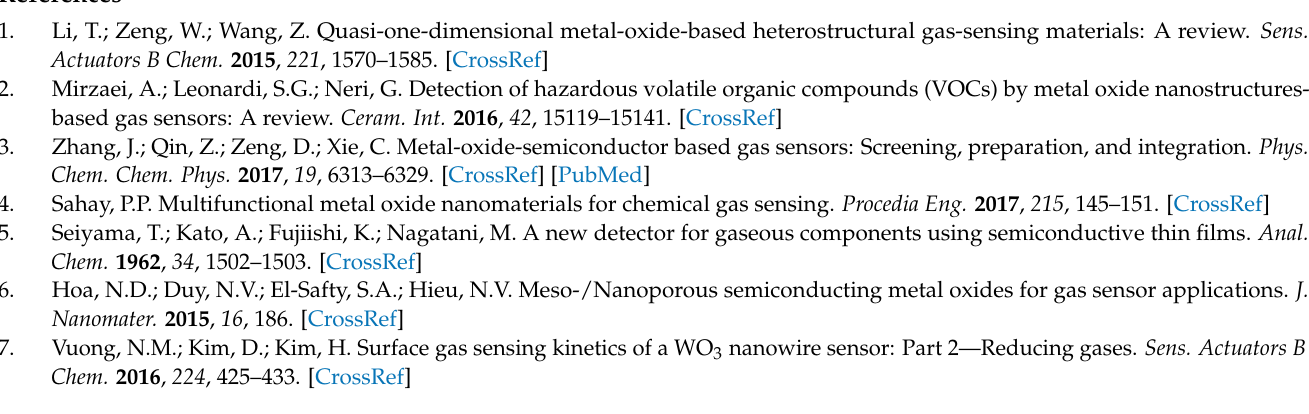
sensing performances. Table S2: The assembled strategies of n-p heterojunctions and their gas sensing performances. Table S3: The assembled strategies of p-n heterojunctions and their gas sensing performances. Table S4: The assembled strategies of p-p heterojunctions and their gas sensing